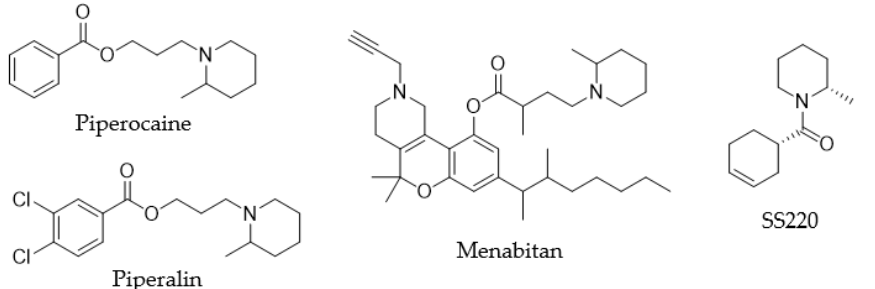
Figure 1. Biologically active compounds containing 2-MPI moiety.